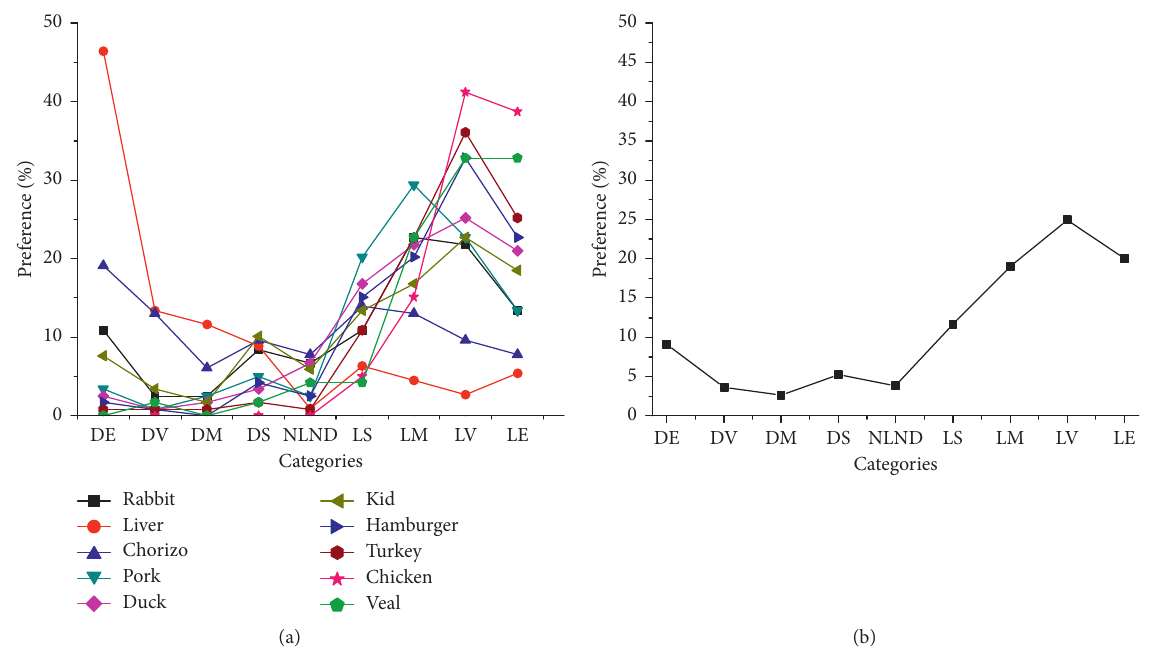
Figure 11: Food preference results. (a) Each beef group food. (b) Beef group as a whole.